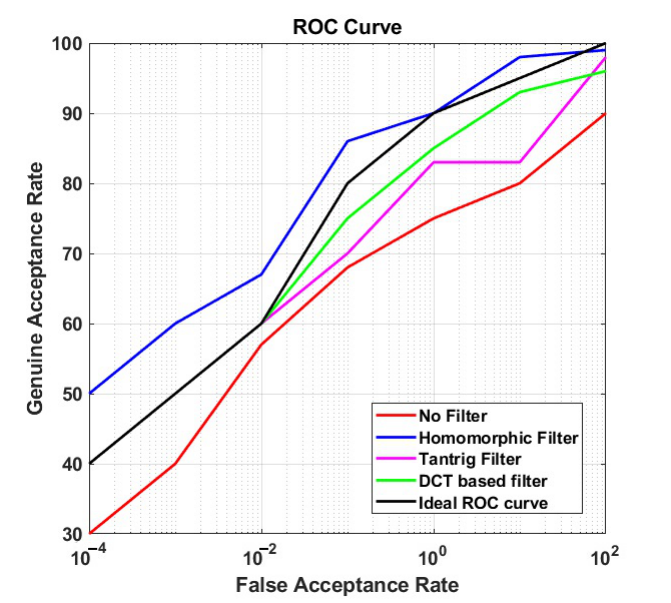
Figure 8. The ROC curves of the proposed method in CSCD face matching.